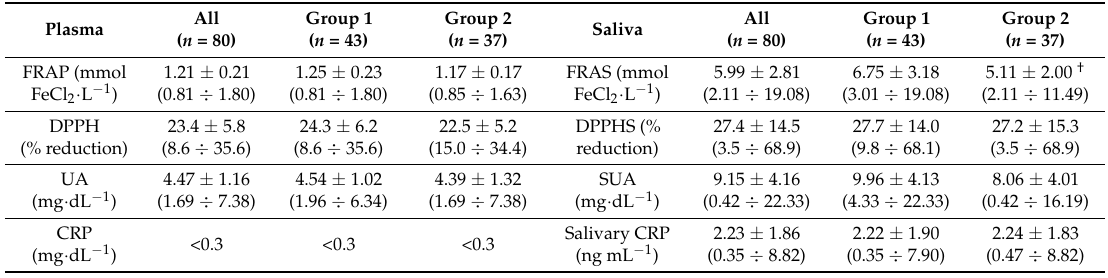
Table 2. Plasma and salivary antioxidant indices and salivary CRP